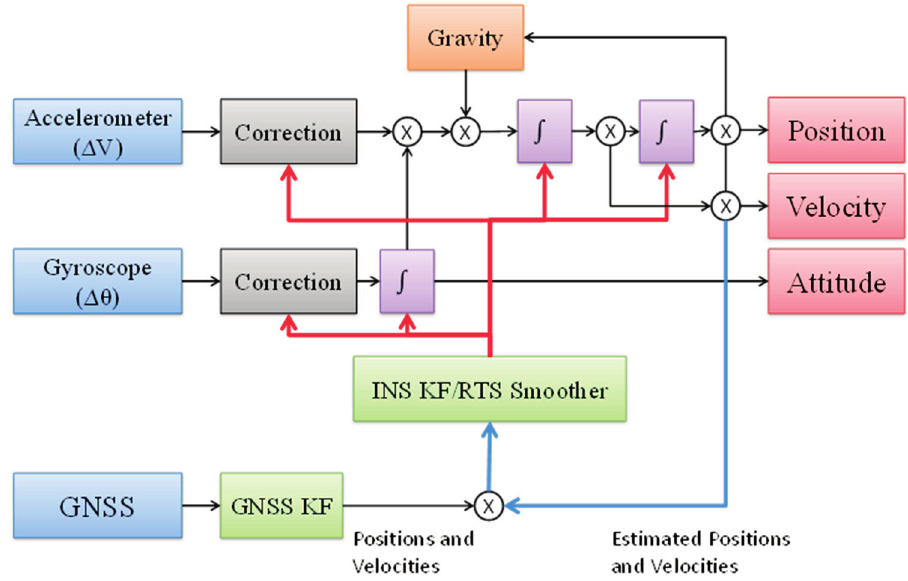
Figure 2. The LC integration